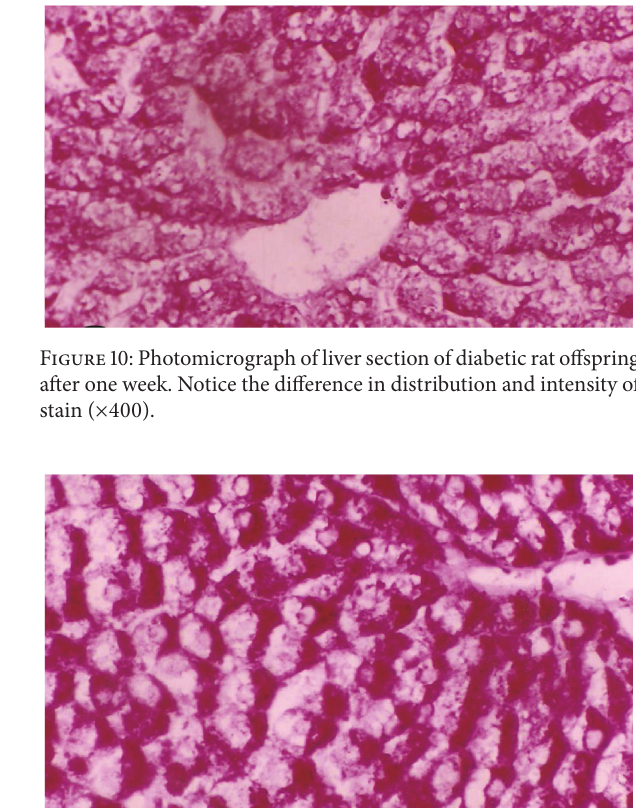
Figure 11: Photomicrograph of liver section of normal rat offspring after two weeks of birth. The stain intensity is much higher than after one week of birth ( × 400).